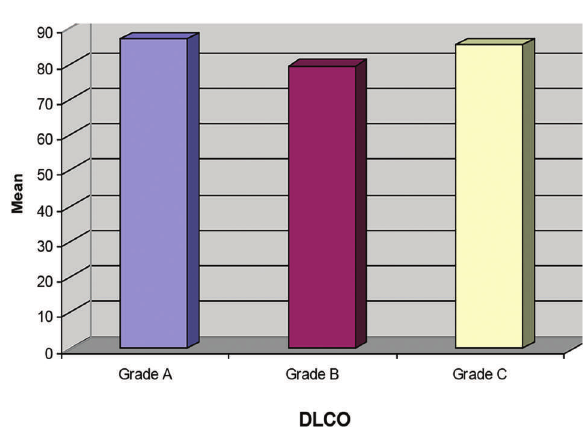
Distribution of DLCO among cases with different grades of reflux. DLCO, diffusing capacity of the lung for